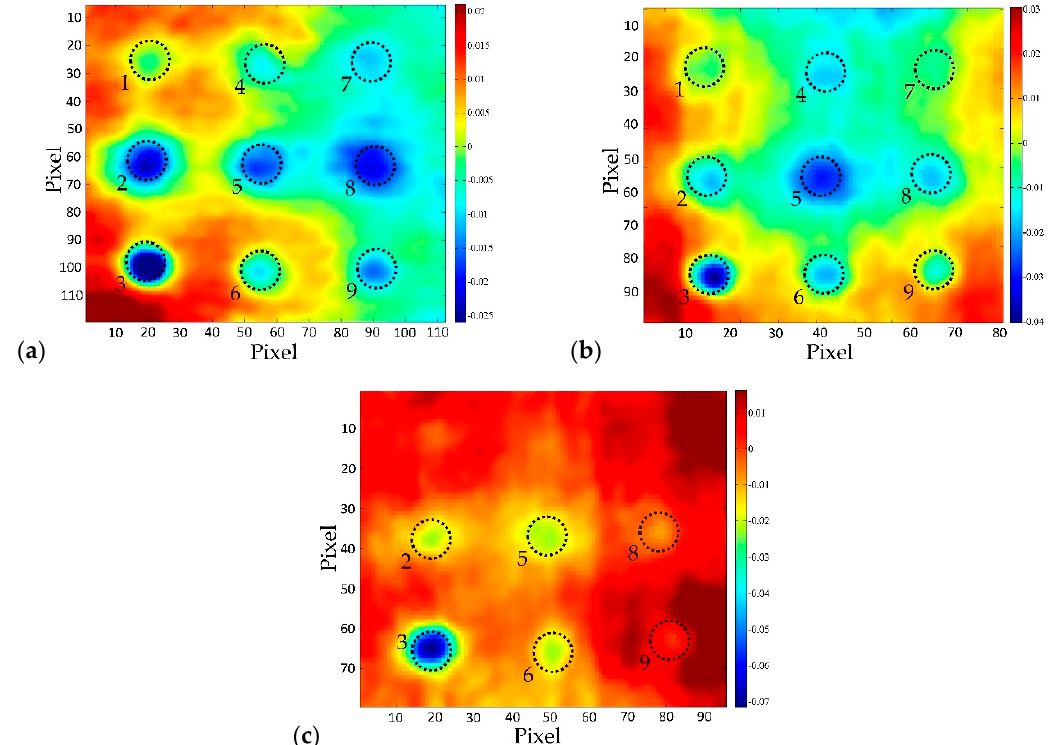
Figure 9. BM 2–2 top side, EOF 2 : ( a ) distance 1.5 m; ( b ) distance 2 m; ( c ) distance 3 m.